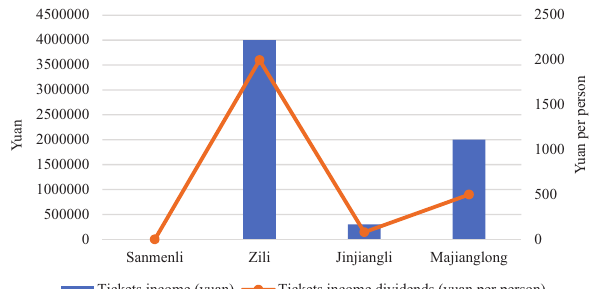
Figure 5. Ticket income and ticket income dividends in Kaiping Diaolou and Villages (source: field survey)